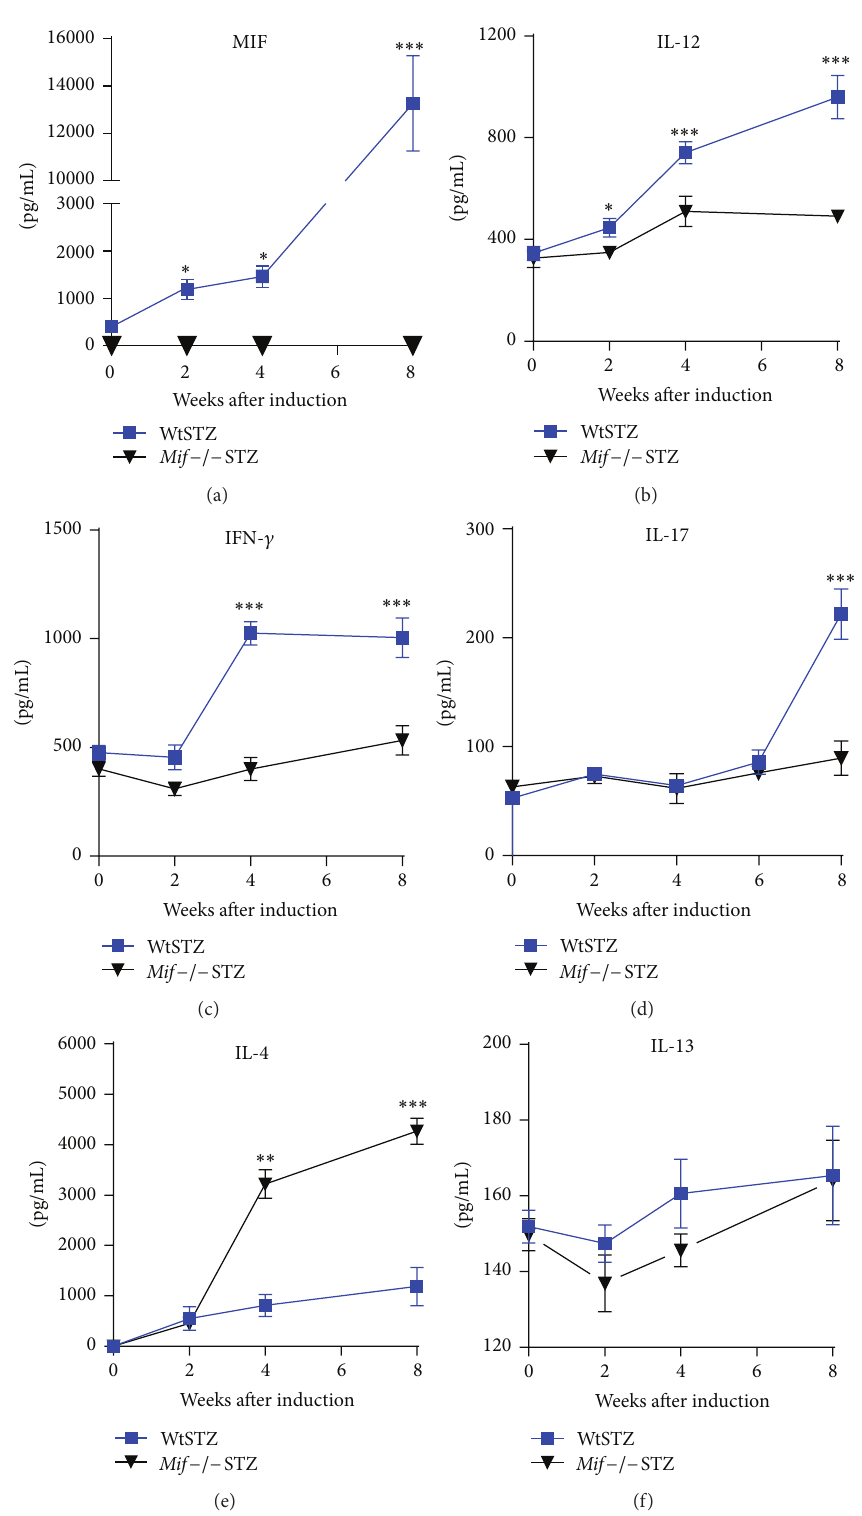
Figure 2: Mif deficiency prevents the elevation of proinflammatory cytokine production . The levels of Mif (a), IL-12 (b), IFN- 𝛾 (c), IL-17 (d), IL-4 (e), and IL-13 (f) in the sera from Wt ( ◼ ) and Mif − / − ( 󳶃 ) mice at 0, 2, 4, and 8 weeks after STZ administration were measured via enzyme-linked immunosorbent assay (ELISA) in triplicate, as indicated in Section 2. Data are expressed as the means ± SE ( n = at least 5–7 mice per group/time point). ∗ 𝑝 < 0.05 , ∗∗ 𝑝 < 0.01 , or ∗∗∗ 𝑝 < 0.001 , GraphPad Prism software